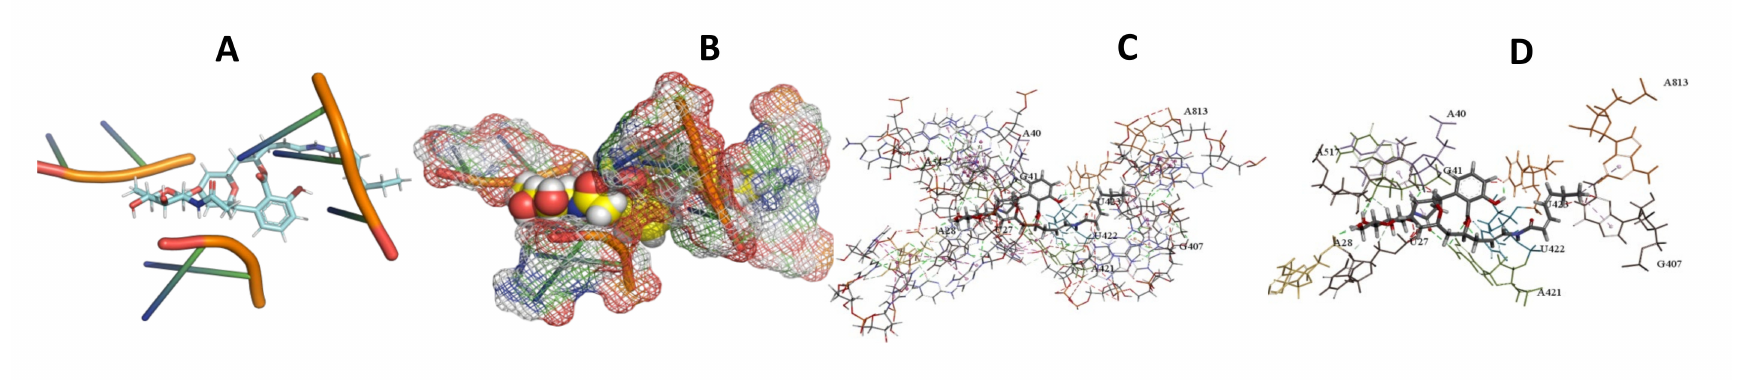
Figure 12. L. major + Apicuralen. ( A ): Best binding pose and nucleotides involved. ( B ): Schematic binding pocket. ( C ): shows the Nucleotides component that re involved in binding. ( D ): Shows the main bonds involved between the compound and the nucleotide component.